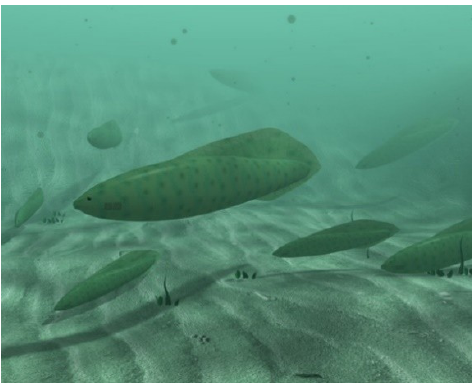
Figure 1. Haikouichthys ercaicunensis . Animals are approximately 2.5 cm in length. Image credit: Talifero. Used here per CC BY-SA 3.0.